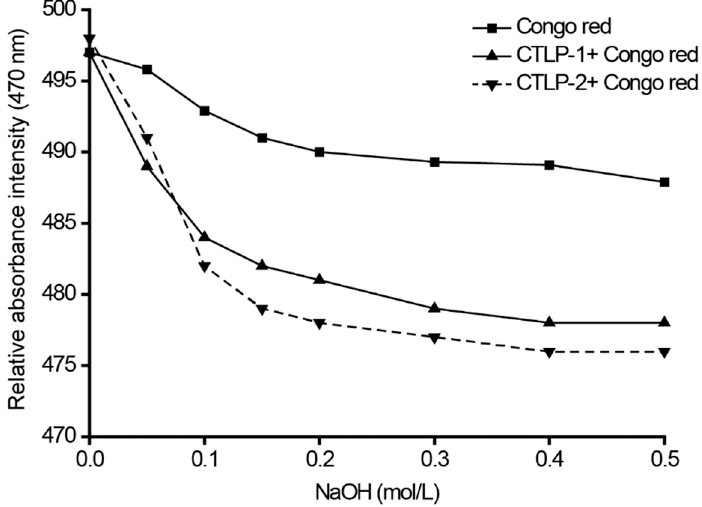
Figure 6. Congo red analysis results for CTLP ‐ 1 and CTLP ‐ 2.